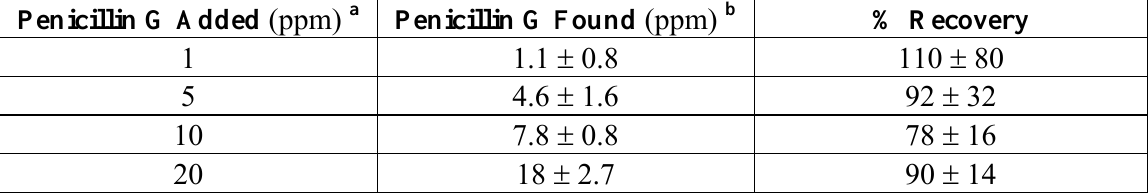
Table 3. Recovery of Penicillin G in Milk Samples with PTy-PNCnase Biosensor. Penicillin G Added (ppm)